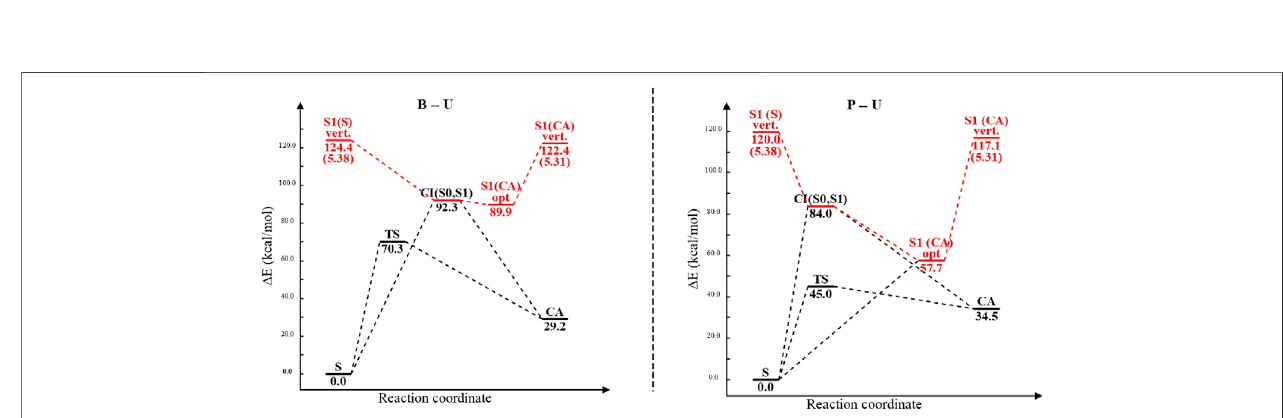
FIGURE 12 | The potential energy pro fi les including equilibrium geometry, vertical excitation, transition state, and conical intersection point energies for the benzene – uracil (B – U) and phenol – uracil (P – U) complexes. Energy values of different conformational barriers are given in kcal/mol, while those in parentheses are in eV. Red path color means the electronic excited-state relaxation, while the blue one represents the ground electronic state relaxation.